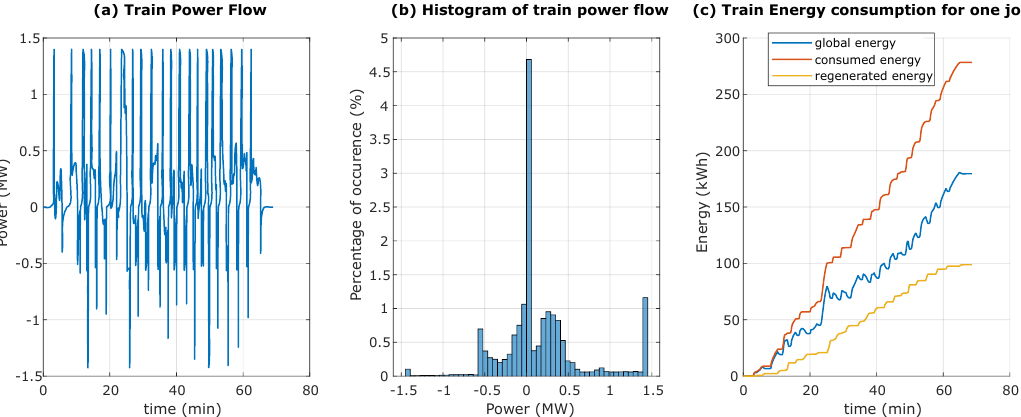
Figure 2. Details on a train journey power flow: a) Power consumption/regeneration for a sub-urban train journey; b) Histogram of train power flow; c) Train energy